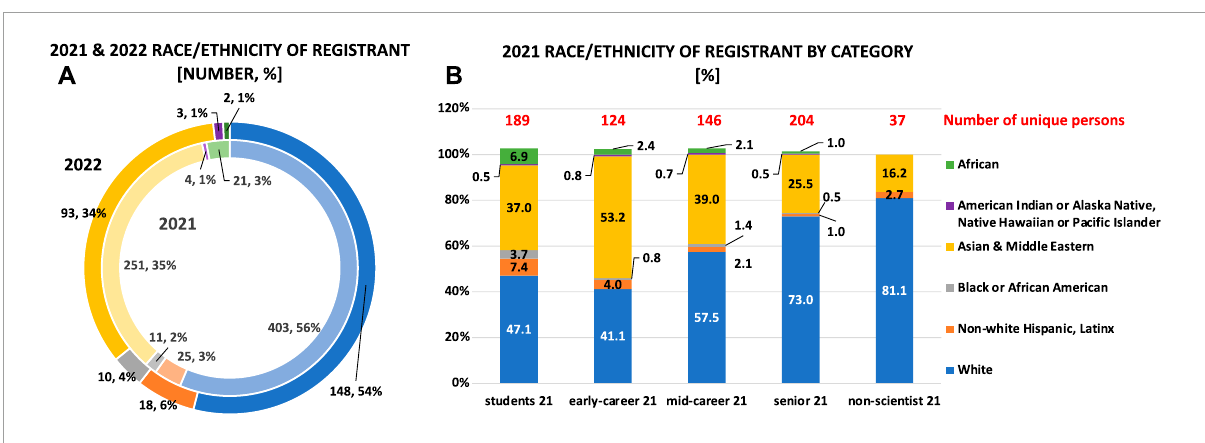
FIGURE 2 (A) Race/ethnicity distribution of the 2021 and 2022 registrants for the Annual CEDAR Workshop in both total number and percentage. Note that multiple races/ethnicities were counted. (B) Race/ethnicity distribution of the 2021 Annual CEDAR Workshop registrants in both total number and percentage. Note that multiple races/ethnicities were counted, and the number of unique persons are shown in red text.